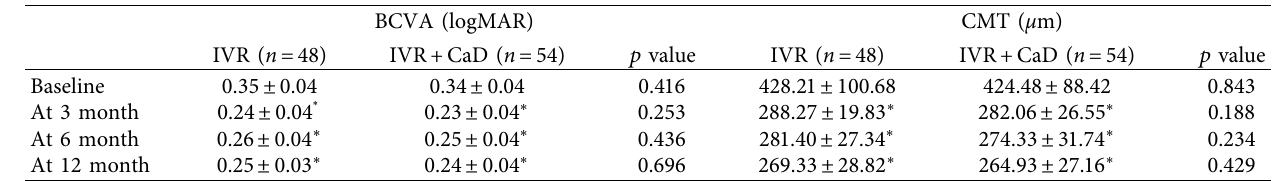
Table 2: Changes of CMT and BCVA after the